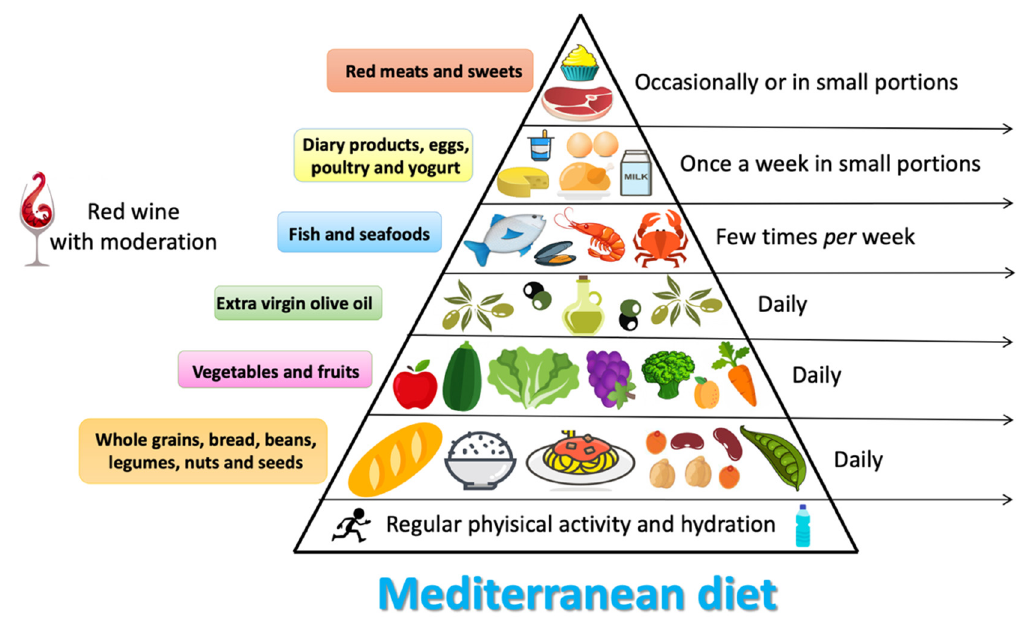
Figure 1. Characteristics of Mediterranean diet.